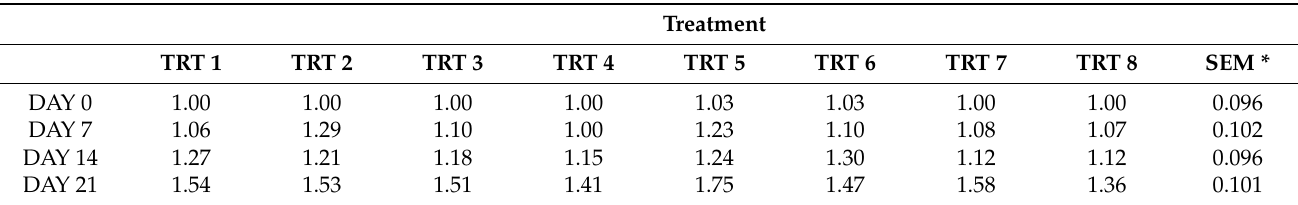
Discoloration percentages (Table 6) of surface color for vacuum-packaged ground beef was not ( p > 0.05) influenced by lean trimmings, packaging materials nor the duration of the simulated display period. Surface color evaluators suggest that vacuum-packaged ground beef discoloration began appearing at the conclusion of the shelf-life (day 21). The lack of surface color changes suggests additional research using visual consumer panelists is necessary to further identify the acceptance of vacuum-packaged fresh meat in the retail setting. Furthermore, evaluation on the duration of shelf-life for vacuum-packaged fresh meat is necessary to determine when the surface color reaches a termination point. Table 6. Influence of packaging film and lean trimmings on percent discoloration color evaluator ratings of ground beef during a simulated retail display shelf life.